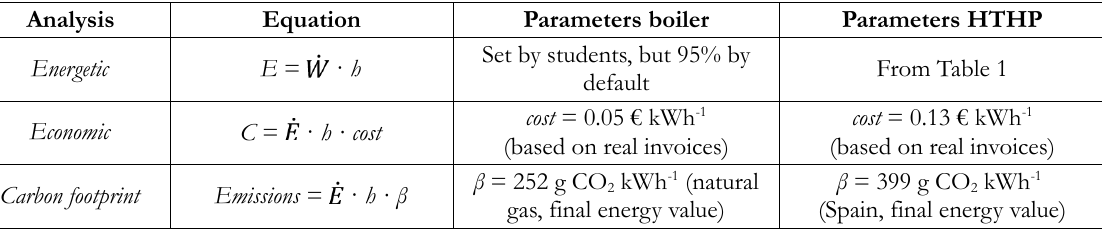
Table 2. Equations used for the multi-purpose comparison of the HTHP and a conventional gas